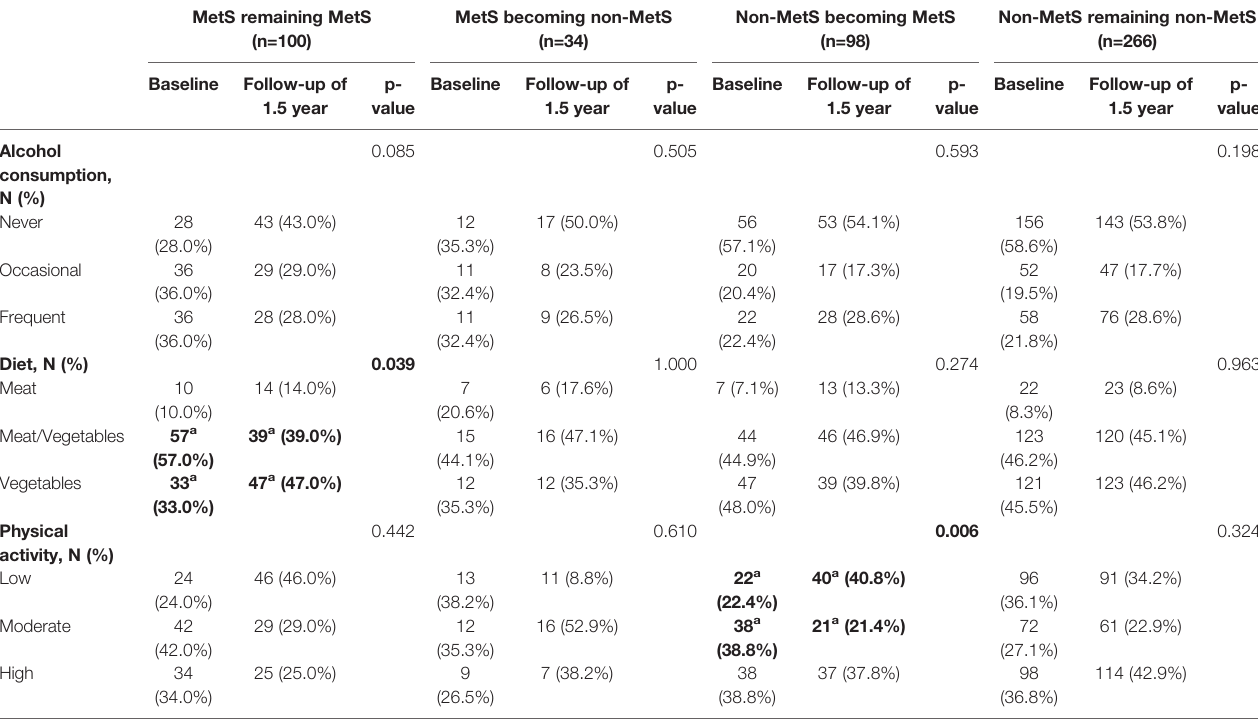
TABLE 3 | Lifestyle change information at baseline and after 1.5 years of follow-up. MetS remaining MetS MetS becoming non-MetS (n=100) (n=34) Baseline Follow-up of 1.5